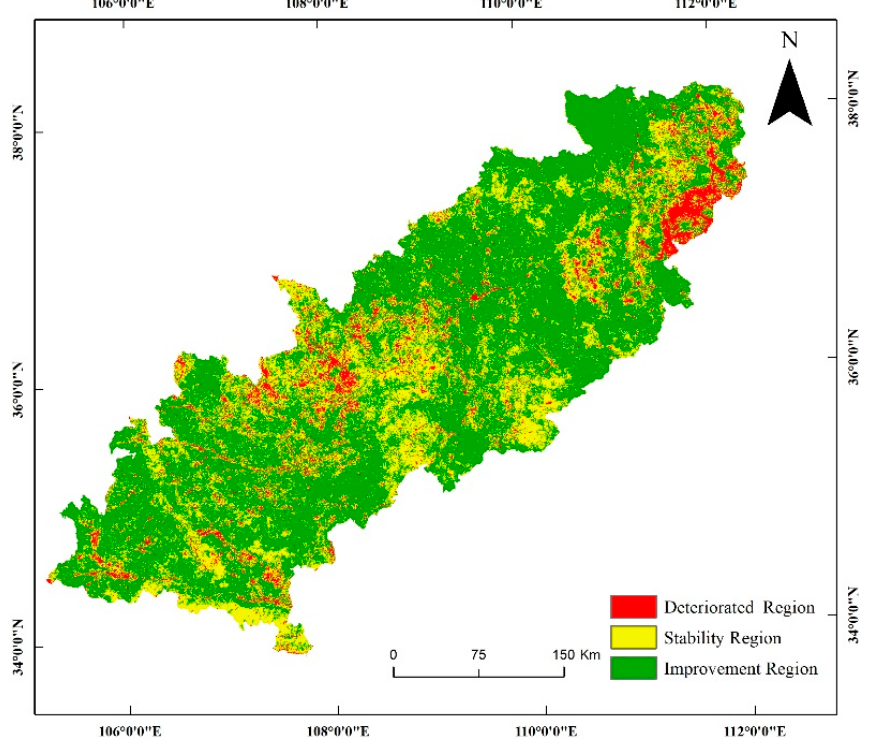
Figure 13. Distribution of changes in LAI in the Loess Plateau Ecological Screen from 2005 to 2015.